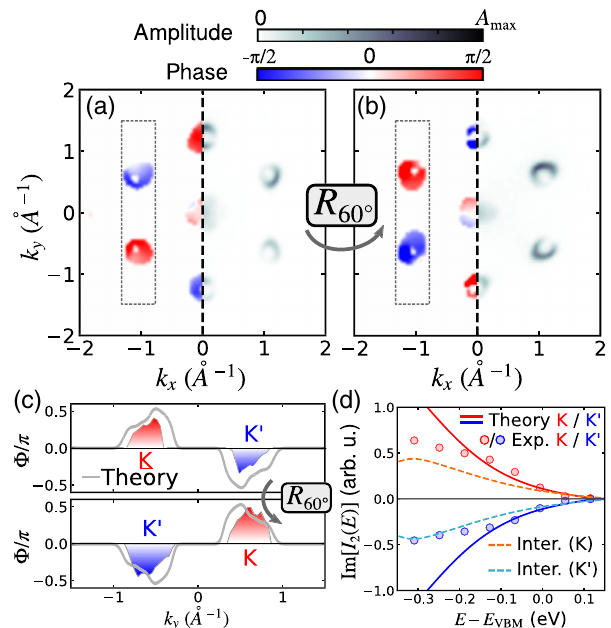
FIG. 4. Energy- and momentum-resolved Fourier analysis of the polarization-modulated ARPES signals. (a,b) Fourier amplitude j I 2 ð E; k Þj (white-to-black color map, right subpanel) and phase Φ ð E; k Þ (blue-to-red color map, left subpanel) of − 0 . 25 eV. the photoemission modulation, for E − E VBM ¼ (c) Averaged phase [along a vertical cut and integrated over k x as indicated by the dashed box in panels (a) and (b)] extracted from both the experimental data in panels (a) and (b) and the theory. (d) Valley-integrated imaginary part Im ½ I 2 ð E Þ(cid:2) of the Fourier amplitude (5), comparing experiment and theory at K (red) and K 0 (blue), respectively. The dashed lines represent the corresponding interference contribution Im ½ I int 2 ð E Þ(cid:2)